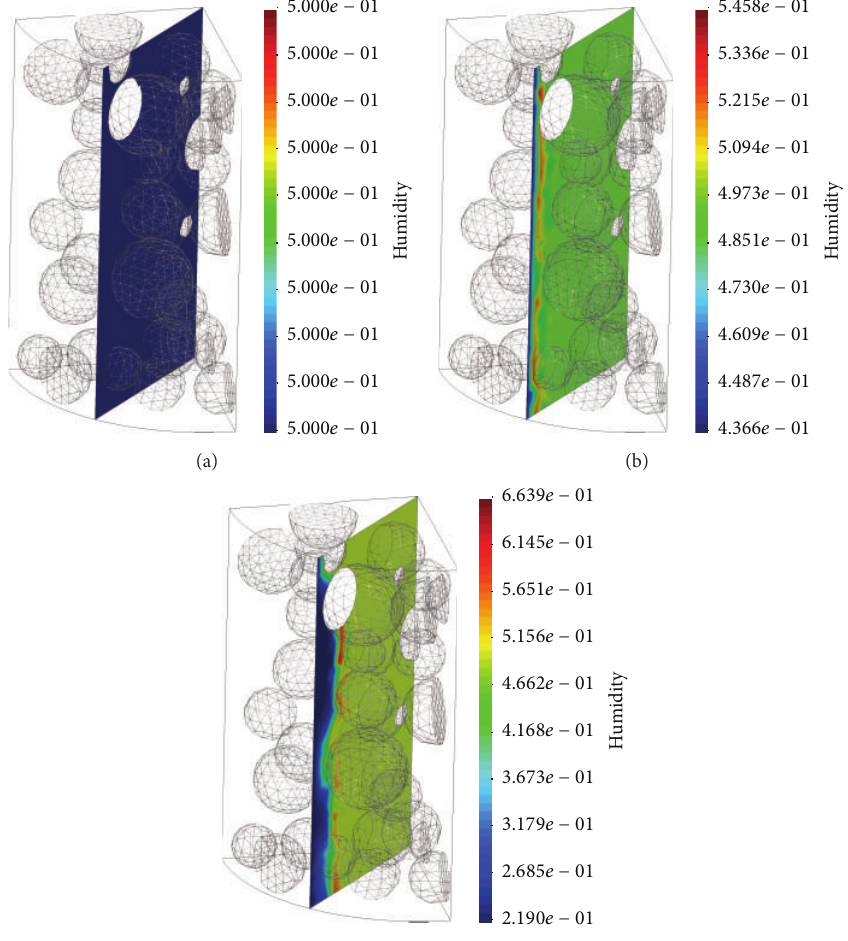
Figure 8: Humidity variation inside the sample at 0.0 min (a); 8.0 min (b); 25.0 min (c) after the start of the analysis.